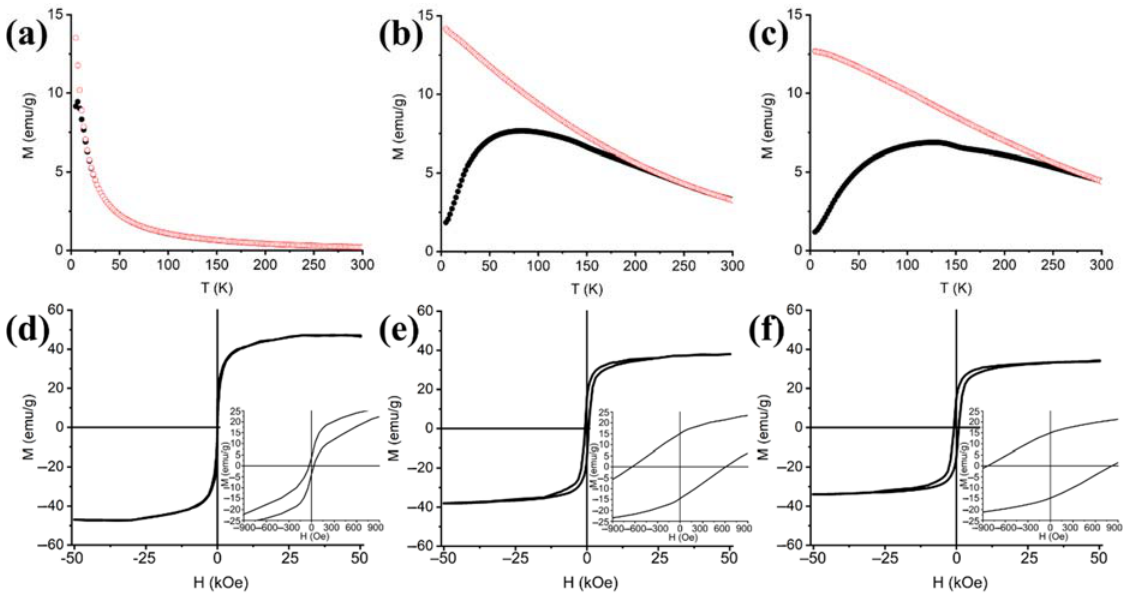
Figure 5. Zero field ‐ cooled–field cooled (ZFC ‐ FC) magnetization curves ( a – c ) and hysteresis cycles ( d – f ) of aerogel samples treated at 900 °C with increasing loading of 5 wt% ( a , d ), 10 wt% ( b , e ) and 15 wt% ( c , f ).